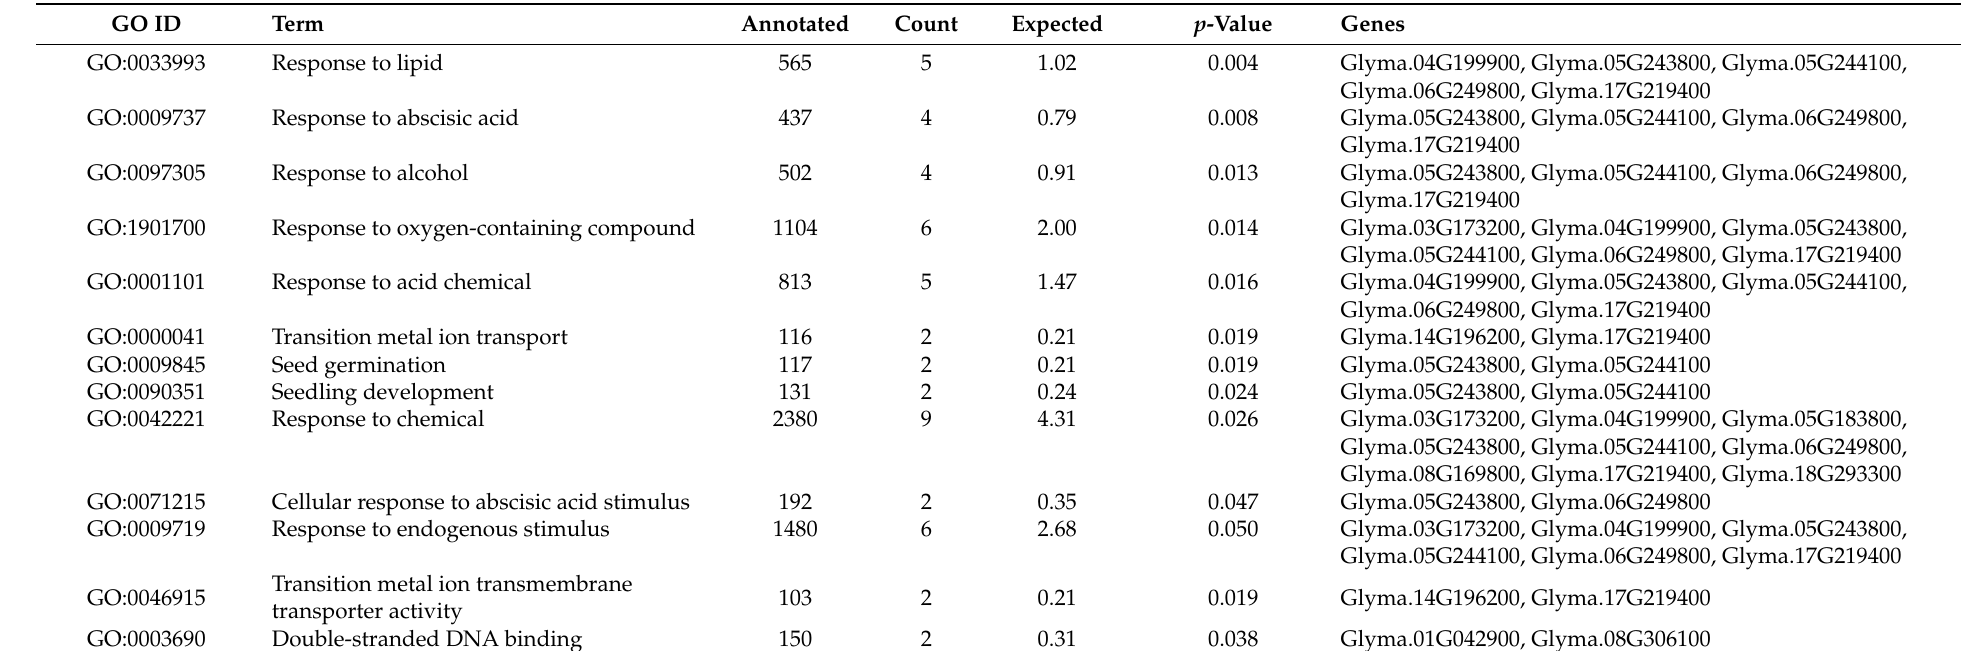
Table 5. Gene ontology annotations of candidate genes related to tocopherol content in